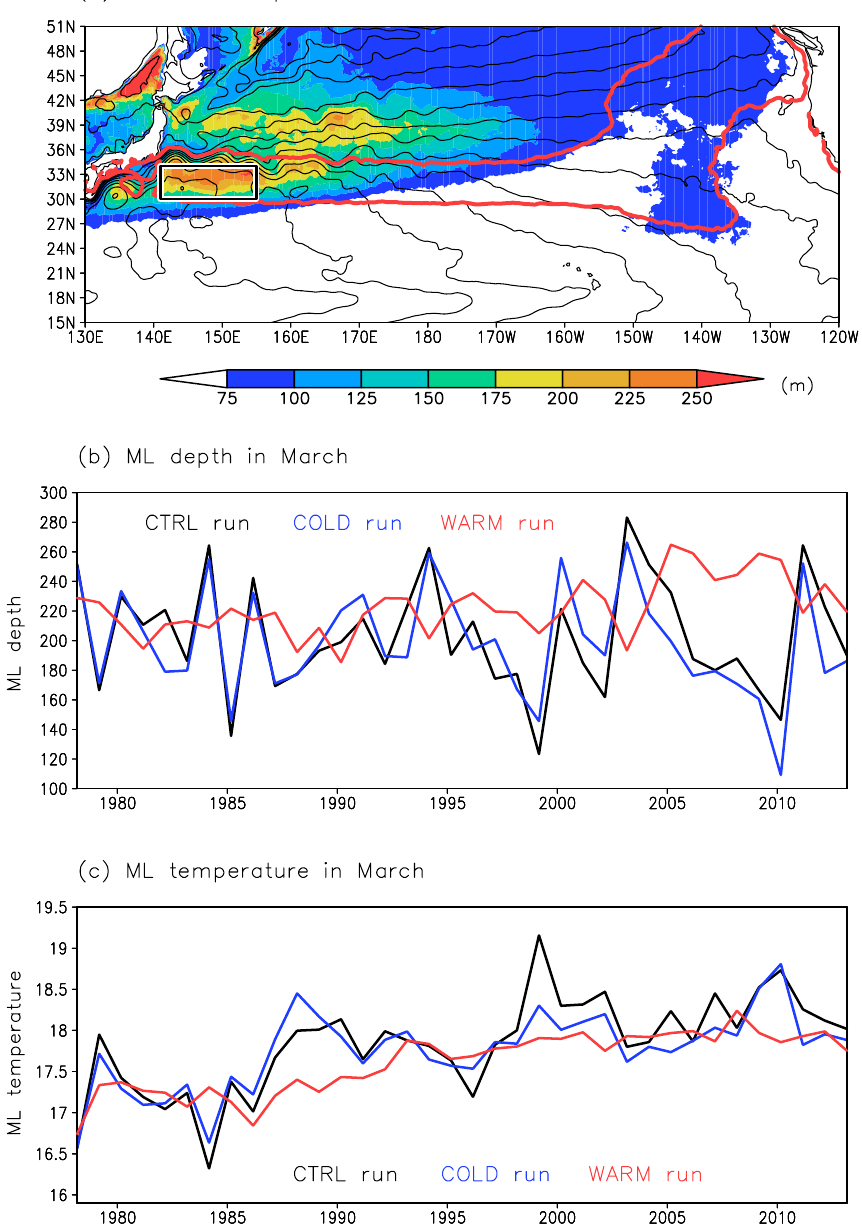
Figure 7. Temporal variations of the late-winter ML in the STMW formation region. ( a ) Distribution of ML depth (m) (shading) and SSH (cm) (contours, 10-cm intervals) in March averaged over 1978–2013 from the CTRL run. The rectangle indicates the STMW formation region (30–34°N, 141–155°E). Red lines indicate the mean positions of the isopycnal outcrops of σ θ = 25.0 and 25.6 kg m –3 in March for 1978–2013. ( b ) Timeseries of ML depth (m) in March in the STMW formation region. Black, blue, and red lines represent the CTRL, COLD, and WARM runs, respectively. ( c ) Same as ( b ), but for ML temperature (°C) in March in the STMW formation